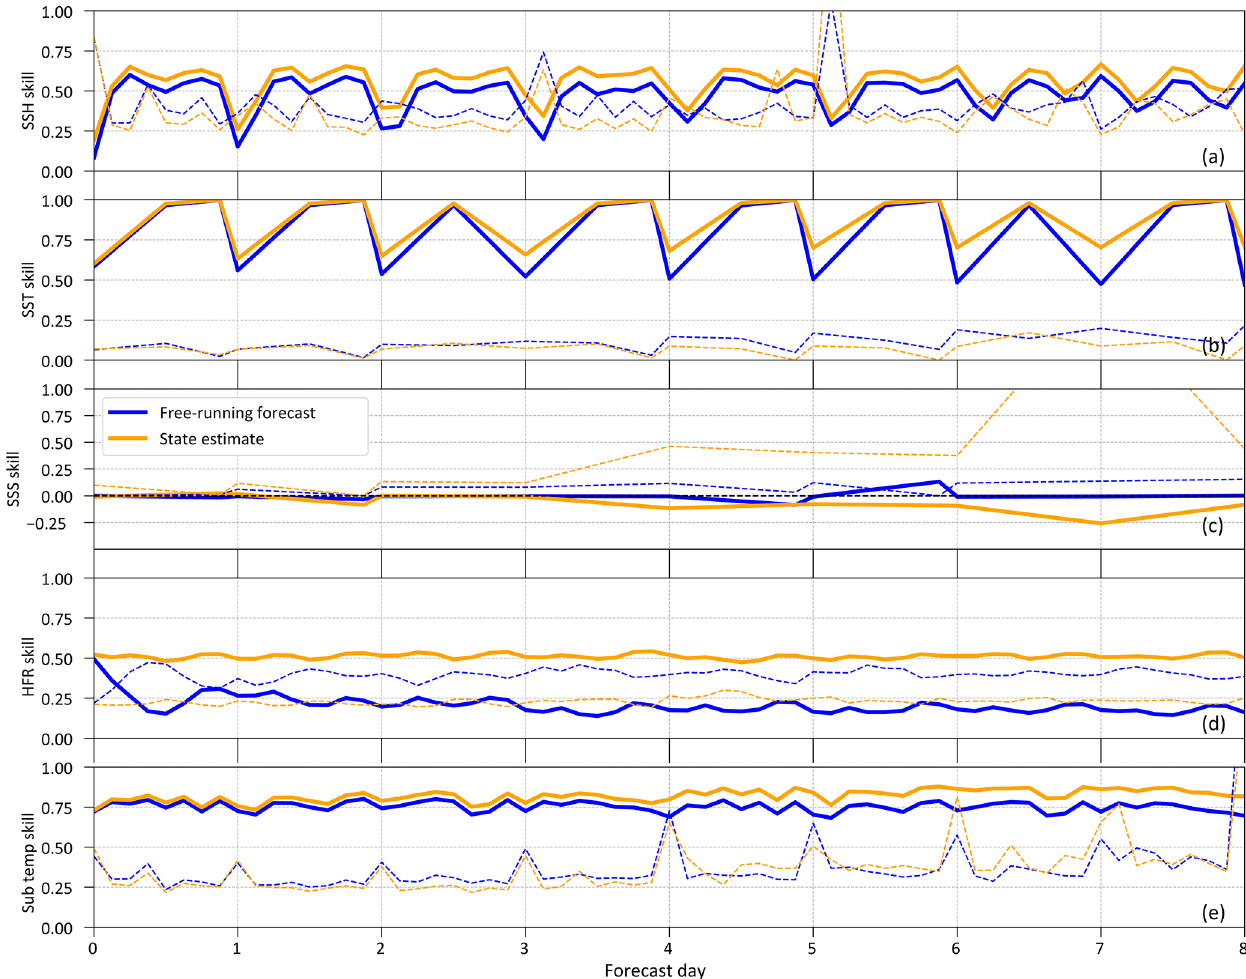
Figure 12. Mean skill metric for remotely sensed observations as a function of forecast length. Solid lines: skill (see Eqs. 10 and 11); dashed lines: standard deviation of skill. (a) Sea surface height; (b) sea surface temperature; (c) sea surface salinity; (d) HFRs; and (e) subsurface